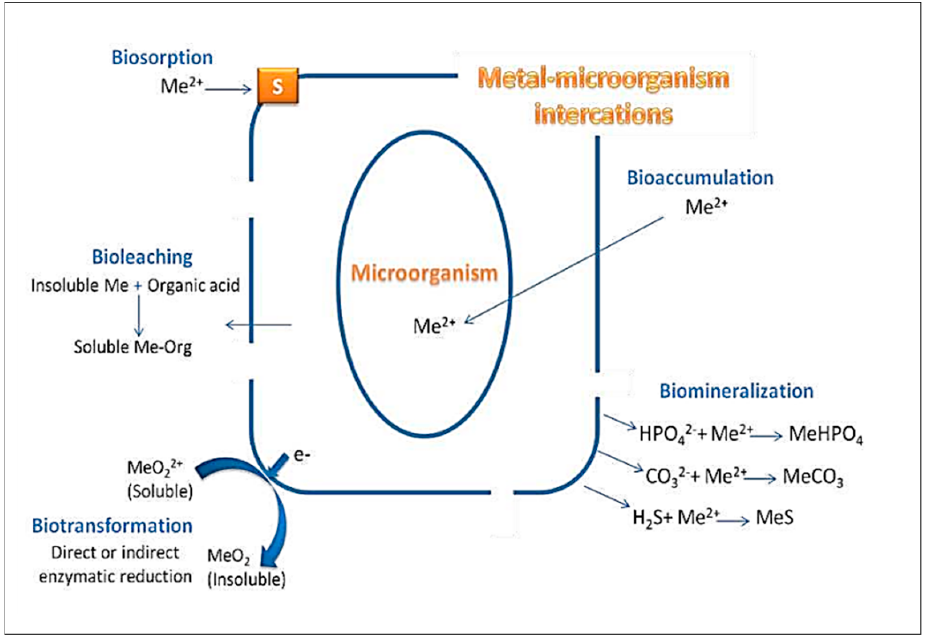
Figure 2. Microbial mechanisms used in metal bioremediation systems adapted and modified from Joutey et al. [6].